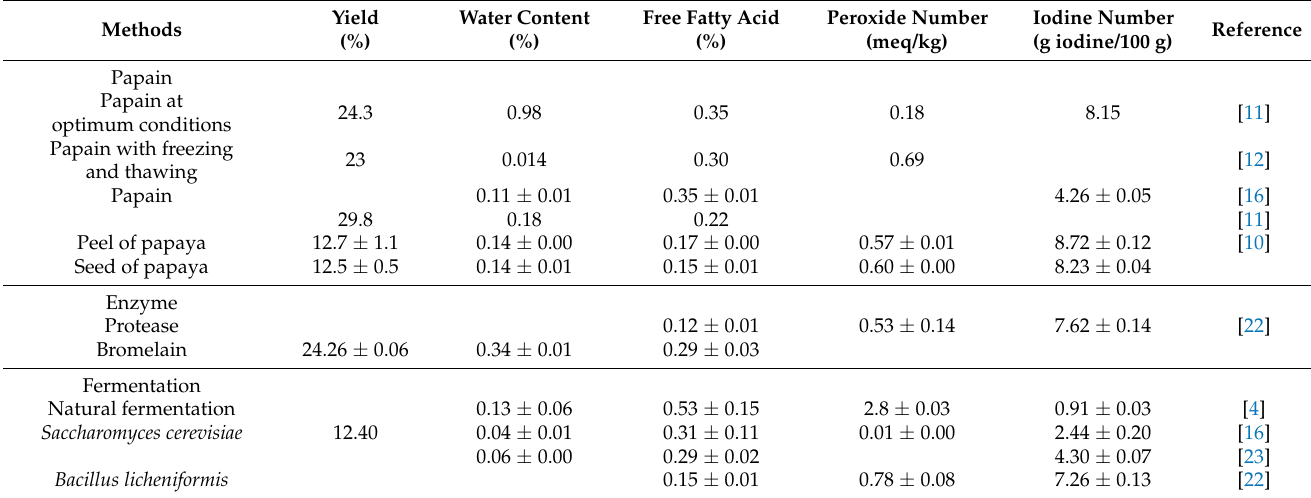
Table 2. Comparison of physicochemical properties of virgin coconut